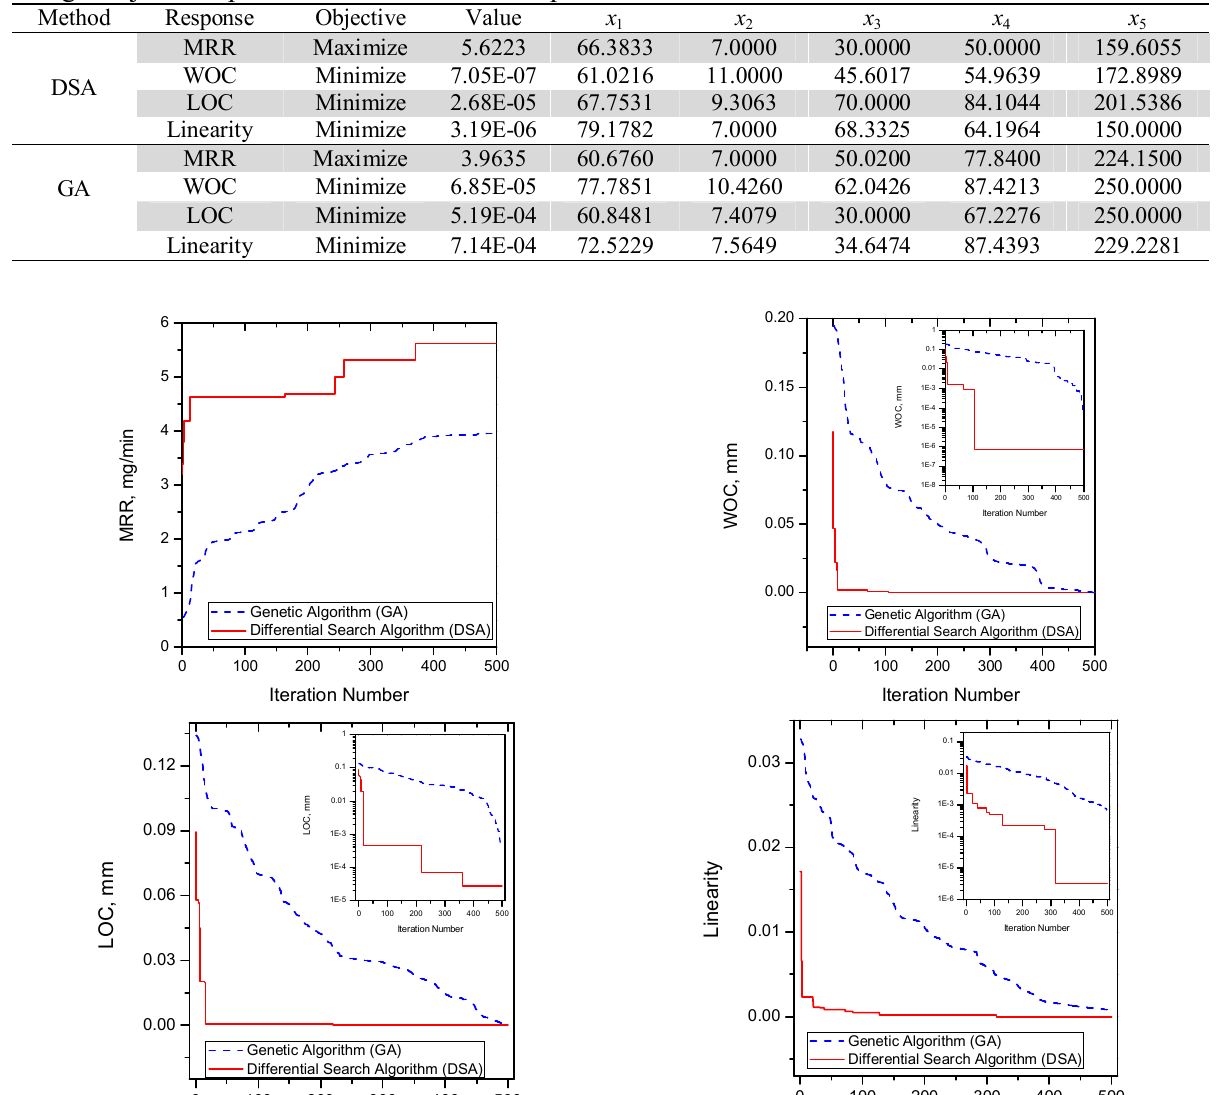
Genetic Algorithm (GA) Differential Search Algorithm (DSA)